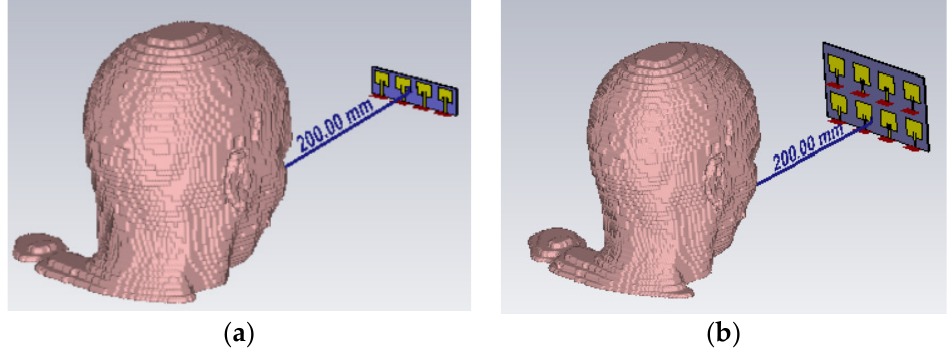
Figure 2. Exposure scenarios: ( a ) linear 1 × 4 patch array antenna and ( b ) planar 2 × 4 patch array antenna